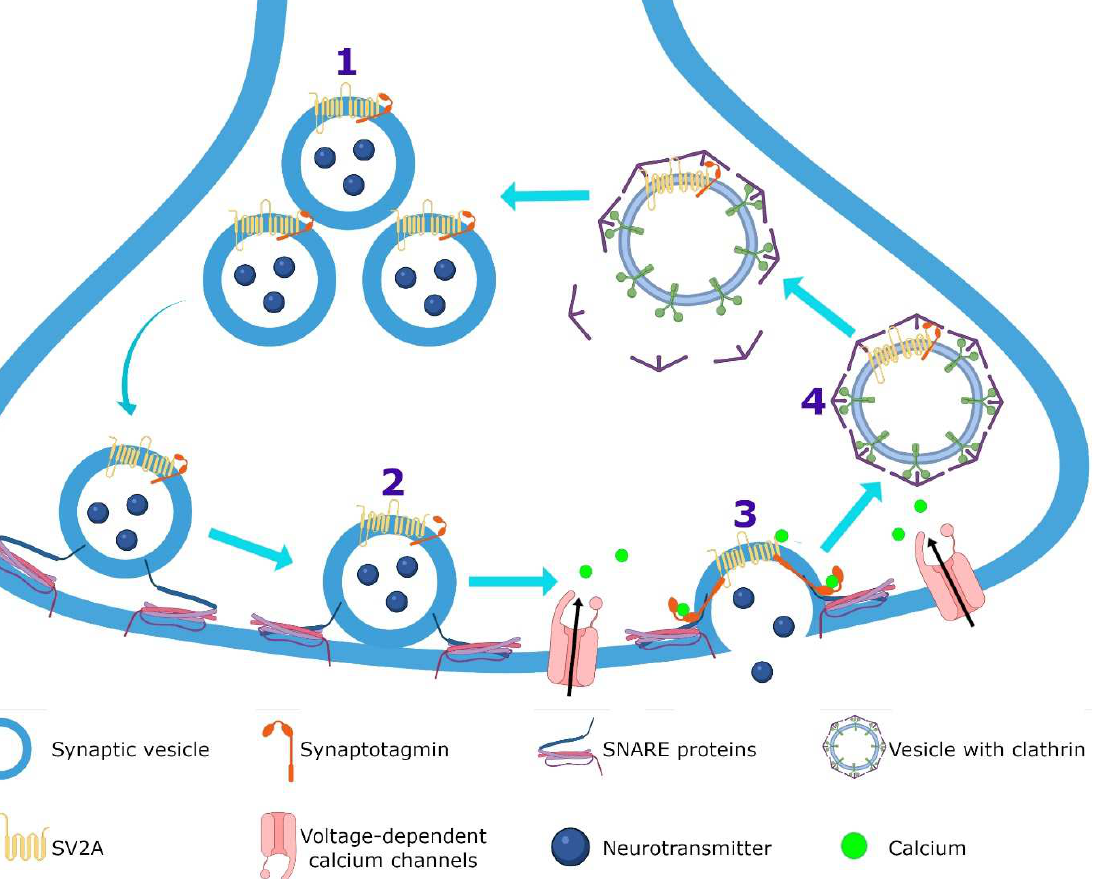
Figure 3. SV2A function. SV2A regulates the readily releasable pool (RRP) size ( 1 ) and during priming ( 2 ) facilitates the progression to the release-competent state, both allowing normal neurotransmission. In the exocytosis ( 3 ), SV2A functions as a target for residual calcium and finally, in the endocytosis ( 4 ), regulates the vesicle content of the calcium-sensor synaptotagmin protein. Furthermore, there are several proposals about how LEV exerts its effect on SV2A.